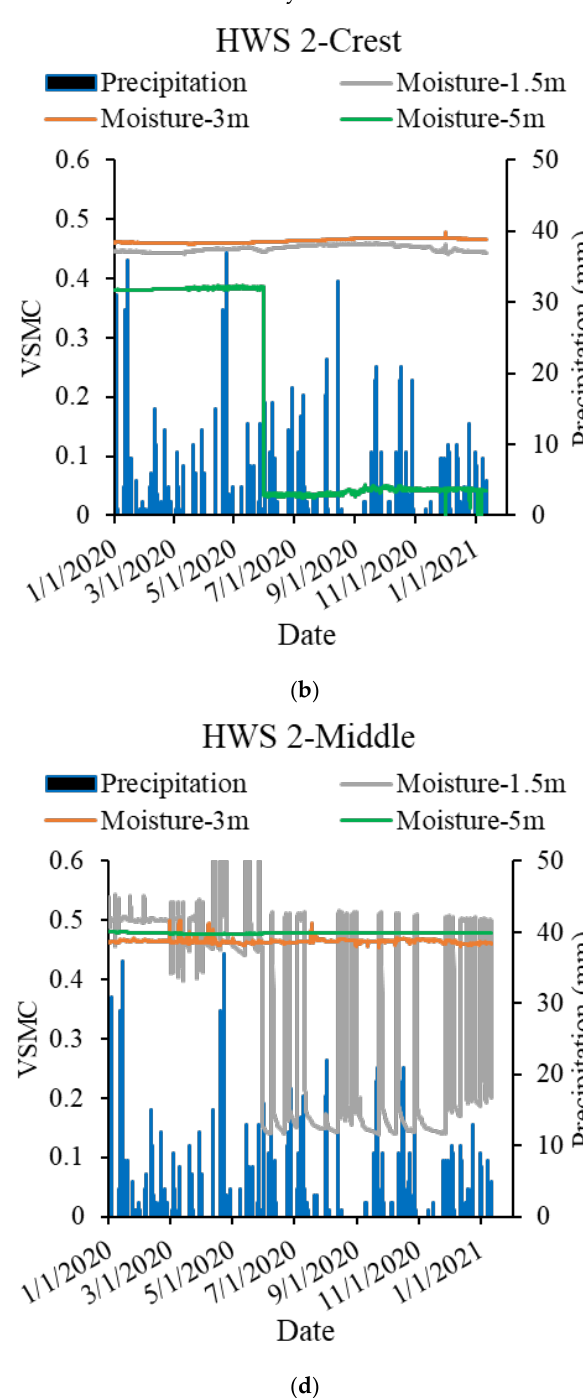
Figure 13. HWS 2 in situ variations with rainfall ( a ) SMS across the crest of the slope ( b ) VSMC across the crest of the slope ( c ) SMS across the middle of the slope ( d ) VSMC across the middle of the slope (1 m = 3.28 ft; 1 mm = 0.039 in; 1 kPa = 20.89